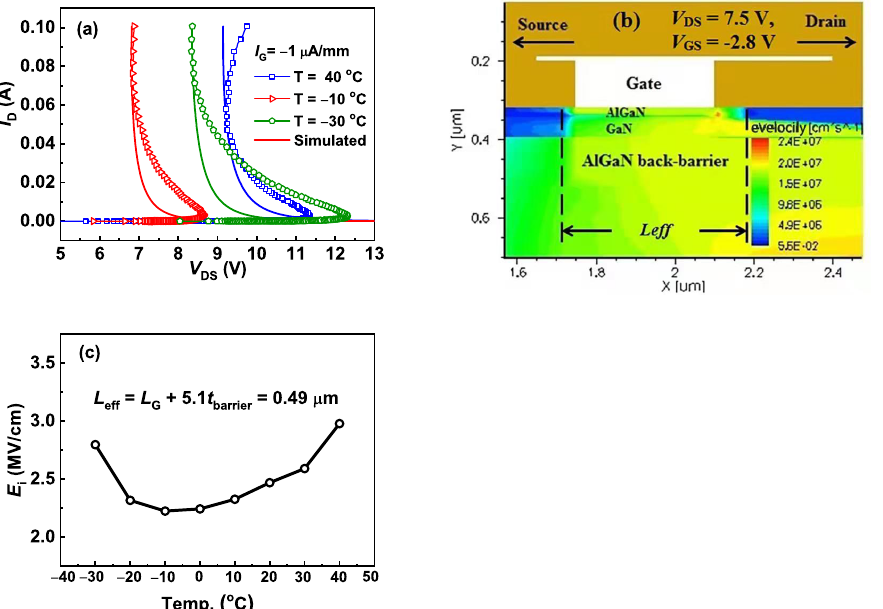
Figure 4. ( a ) Impact ionization modeling of the measured BV ON loci for the fabricated AlGaN/GaN HEMTs. ( b ) Value of effective gate length obtained by simulation in condition of ON-state breakdown measurement at V DS = 7.5 V and V GS = − 2.8 V. ( c ) Evolution of the extracted E i with